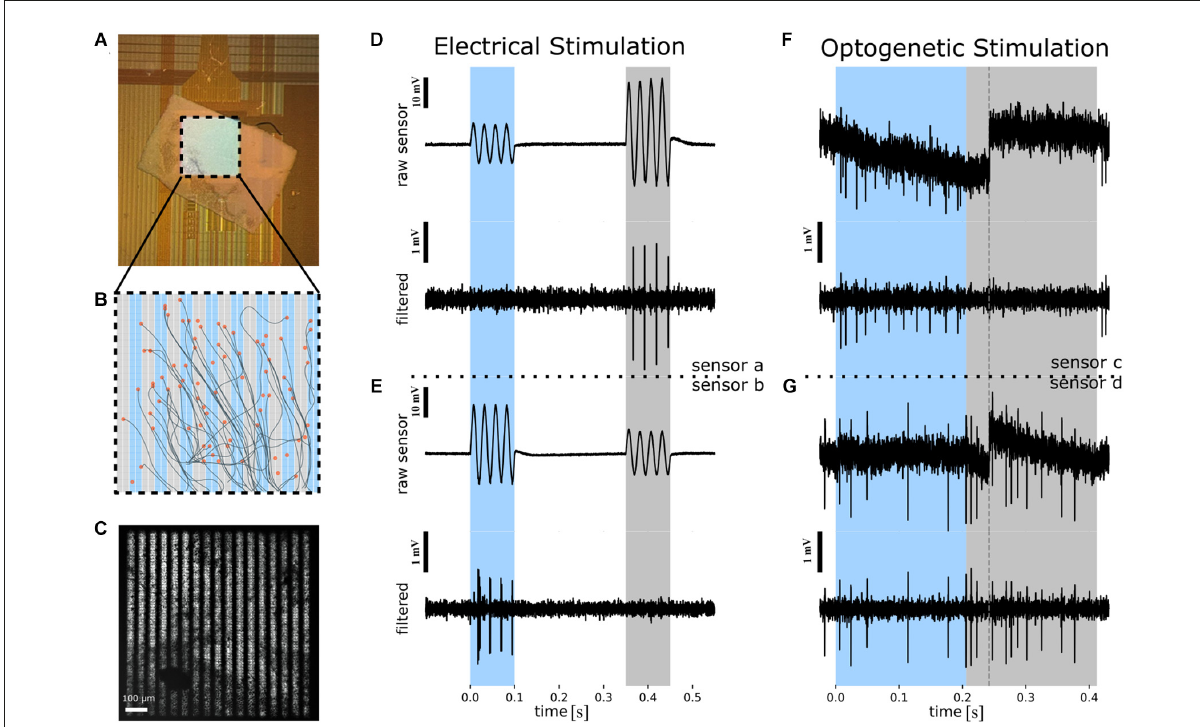
FIGURE1 Overview of the experimental protocol used to infer the spatial resolution of the stimulus based on the RGC spiking. (A) Photograph of ex vivo rd10 retina interfaced to a CMOS-MEA. The central square (1 × 1 mm 2 ) comprises 1,024 capacitive stimulation electrodes and 4,225 recording sites. (B) Schematic of the stimulation array with 1,024 stimulation electrodes. The recording sites are in the same area, with each stimulation electrode being enclosed by four recording sites (not shown here). Cell positions (orange circles) and inferred axon pathways are shown. In the background (blue and gray) the two phases of the reversed grating stimulus are shown. (C) Microscopic image of the retina on the CMOS MEA with the optogenetic photo-stimulation pattern superimposed. Scale bar: 100 µ m. (D) The electrical stimulation protocol exemplified using the raw voltage of one recording sensor (recording site a ). Upper panel : Four sinusoidal stimulation waveforms were applied to “blue” stimulation electrodes (panel B ) between 0 and 100 ms, followed by four stimulation waveforms applied to the “gray” electrodes (panel B ) between 350 and 450 ms. The selected recording sensor records a higher extracellular voltage artifact for stimulation with gray stimulation electrode as compared to stimulation with blue electrodes. Note that the same stimulus amplitude was applied to “blue” and “gray” electrodes. Scale bar: 10 mV. Lower panel : High-pass filtered extracellular voltage of the signal shown in the upper panel reveals spiking in each cycle of the four sinusoidal waveforms for stimulation with the gray electrodes only. Scale bar: 1 mV. (E) Detection of selective electrical activation revealed by a second sensor (“recording site b”). Description of the traces as in (D) . (F) The optogenetic stimulation protocol exemplified using the raw voltage of one recording sensor (recording site c ). Upper panel : Spatially patterned photo-stimuli with fine gratings were projected onto selected regions of the CMOS sensor array (see panel C ) between 0 and 200 ms, followed by a reverse grating between 200 and 400 ms. Dashed line in the raw extracellular voltage trace marks a sensor reset. Scale bar: 10 mV. Lower panel : High-pass filtered extracellular voltage of the signal shown in the upper panel reveals spiking during one of the stimulation phases (marked with “blue”). (G) Detection of selective optogenetic activation revealed by another sensor (“ recording site d ”). Description of the traces as in (F) . RGC, retinal ganglion cell; CMOS MEA, Complementary Metal-Oxide- Semiconductor microelectrode